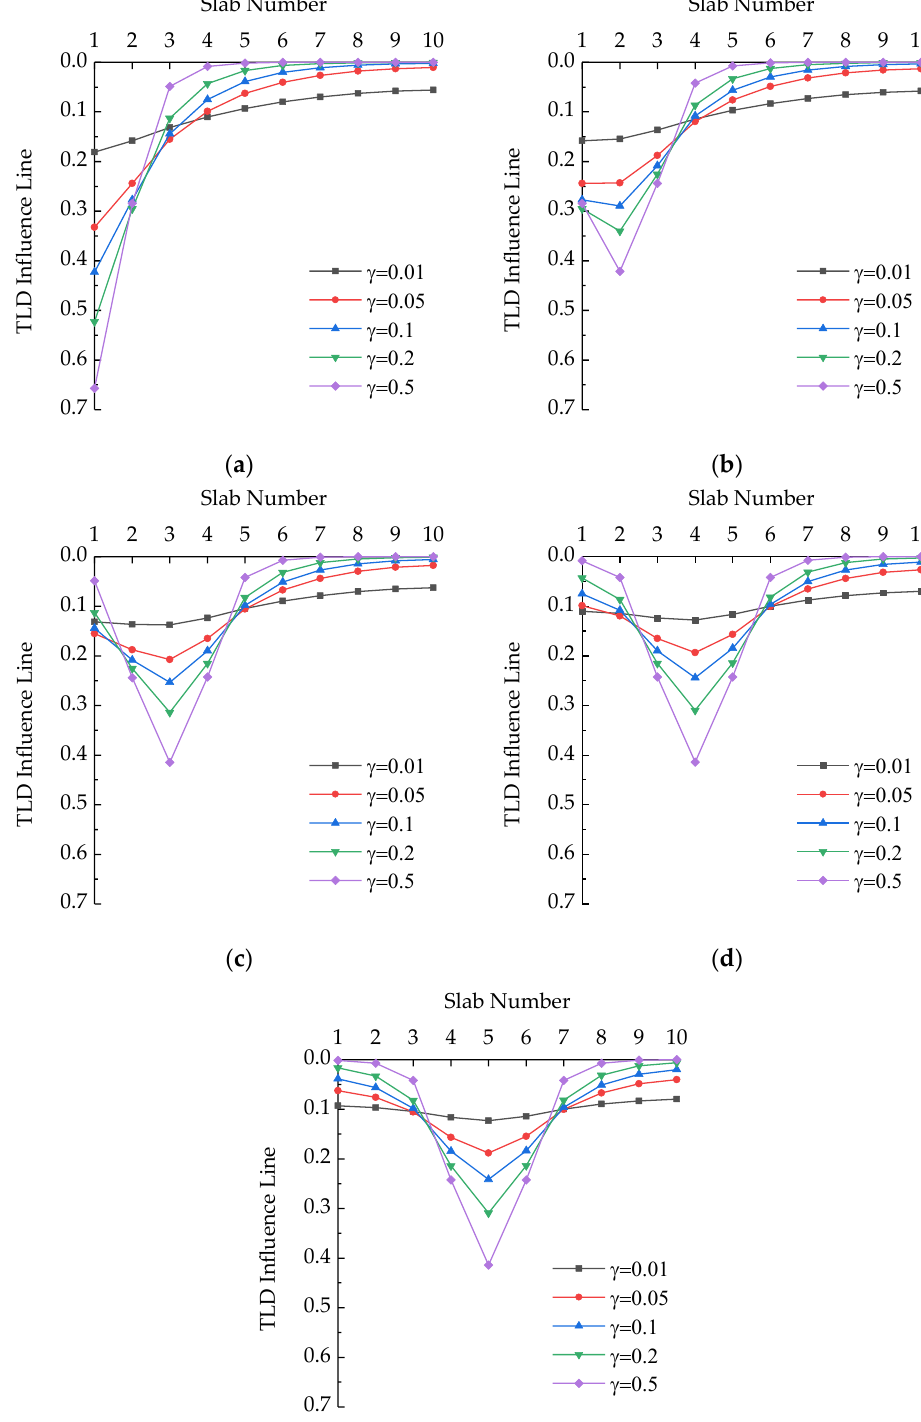
Figure 15. The influence lines of TLD for each slab at different relative stiffness.